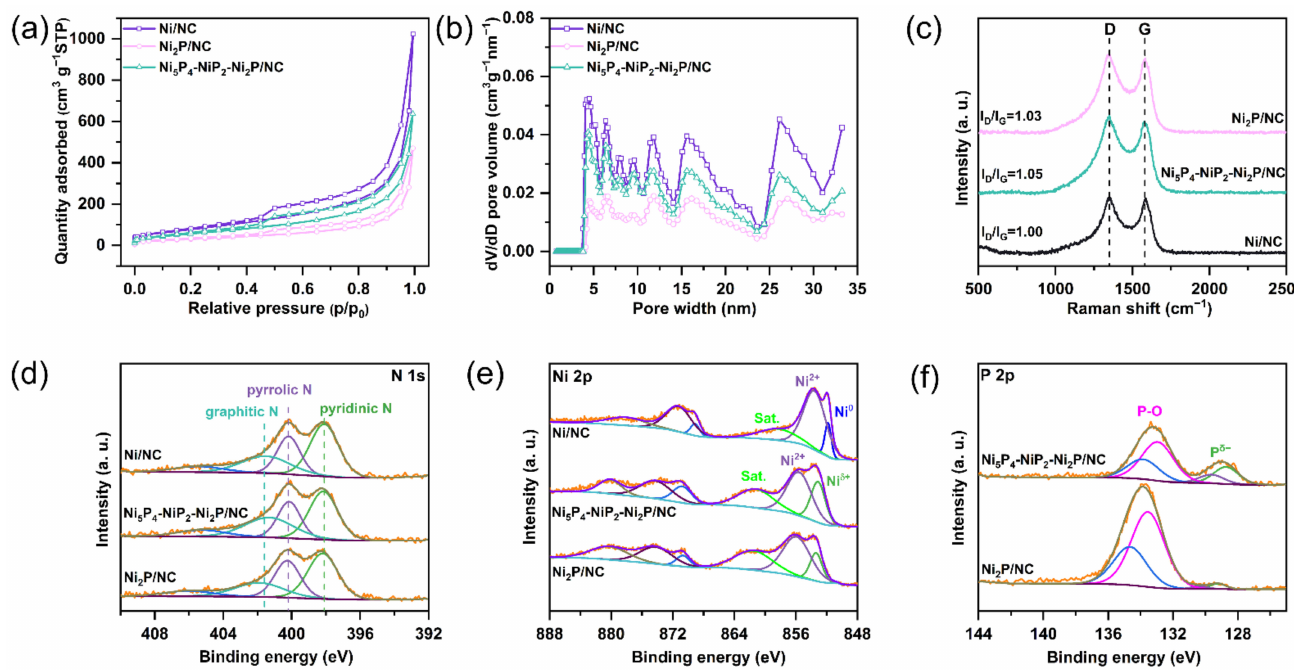
Figure 4. ( a ) N 2 adsorption–desorption isotherms and ( b ) pore-size distribution of the samples Ni/NC, Ni 2 P/NC, and Ni 5 P 4 -NiP 2 -Ni 2 P/NC; ( c ) Raman spectra of Ni/NC, Ni 2 P/NC, and Ni 5 P 4 - NiP 2 -Ni 2 P/NC; High-resolution XPS spectra of ( d ) N 1s, ( e ) Ni 2p, and ( f ) P 2p for all